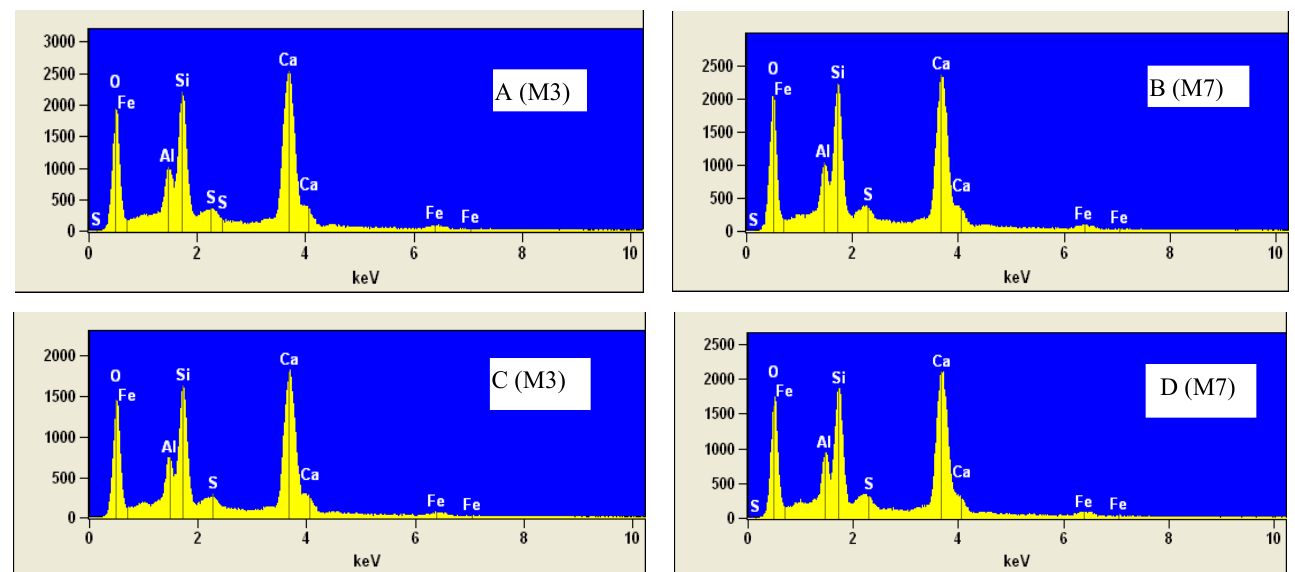
Figure 10. ( A – H ) SEM images of test block samples of different mixes containing different dosages of SAP and nano-silica without superplasticiser; ( I – P ) SEM images of test block samples of different mixes containing different dosages of SAP and nano-silica with a constant dosage of superplasti- ciser (0.5%).